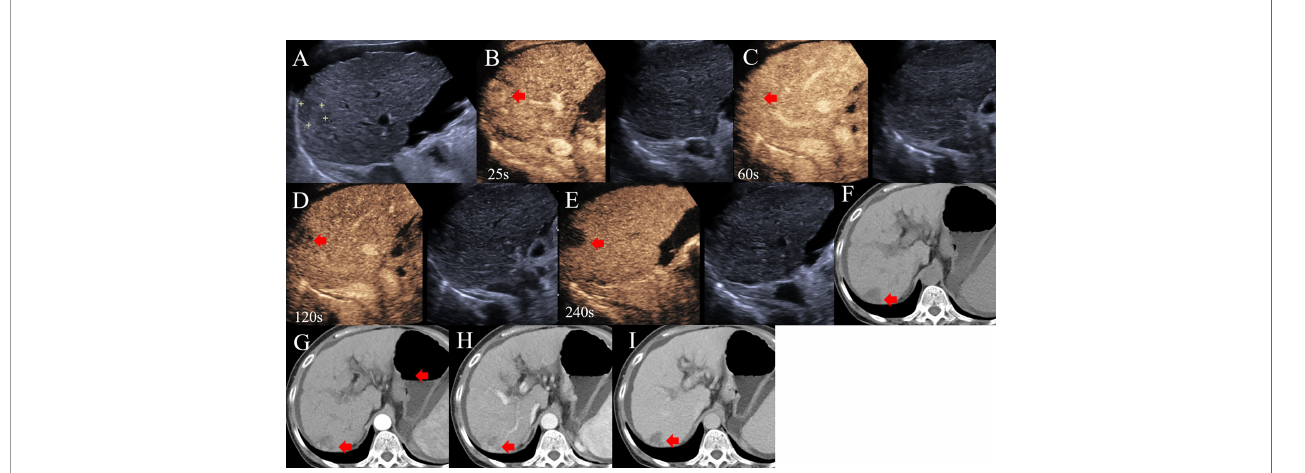
FIGURE 2 | A 68-year-old woman with HBV related liver cirrhosis and elevated AFP (1210ng/ml) and CA19-9 (43.03 ng/ml). (A) A hypo-echoic lesion with a size of 1.9cm was observed by US. (B) The lesion showed APHE on CEUS; (C) without washout 1 min after injection of contrast agent; (D) Delay and mild washout was observed 2 min after injection; (E) The lesion appeared punched-out 4 min after injection of contrast agent. The lesion was categorized to CEUS LR-5. (F) A hypo- intensive lesion was found on CT; (G, H) The heterogeneous enhancement was observed on the arterial and portal phases of contrast enhanced CT; (I) The lesion was hypo-intensive on the delay phase and classi fi ed into CT LR-5. The fi nal diagnosis was cHCC-CCAs, as con fi rmed by pathology.